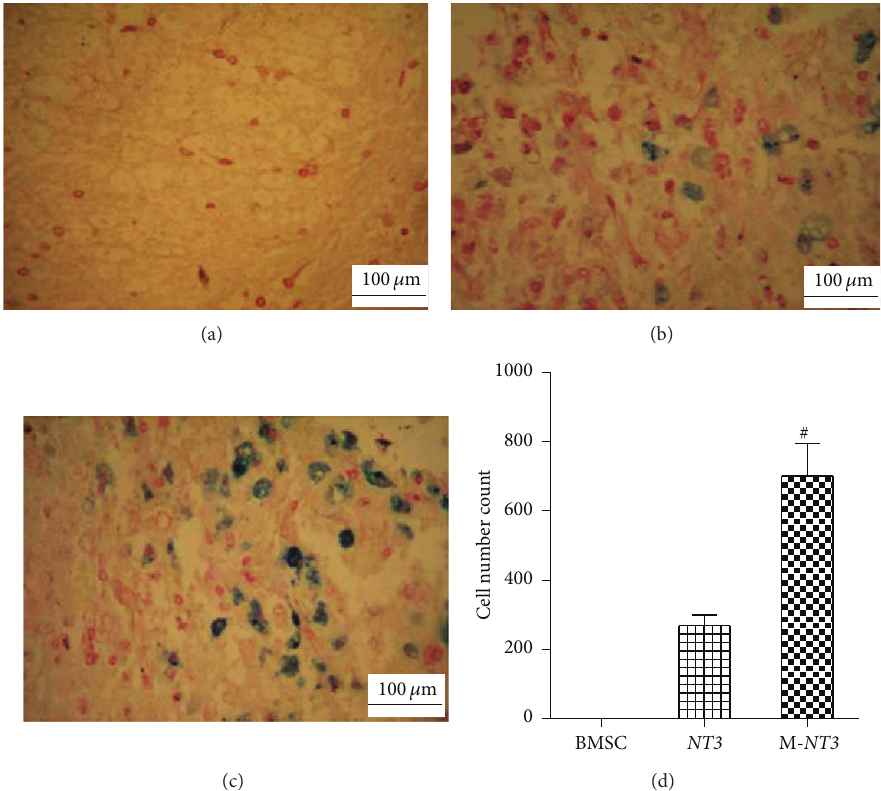
Figure 5: Prussian blue staining of tissues around the injured spinal cord lesion on day 35 after transplantation in the BMSC group (a), NT3 group (b), and M- NT3 group (c). Magnification, × 200 ((a), (b), and (c)). Scale bar, 100 𝜇 m ((a), (b), and (c)). (d) The data, which are presented as the means ± SD ( 𝑛 = 12 ), were analyzed using the Mann-Whitney 𝑈 test. # 𝑝 < 0.05 versus the NT3